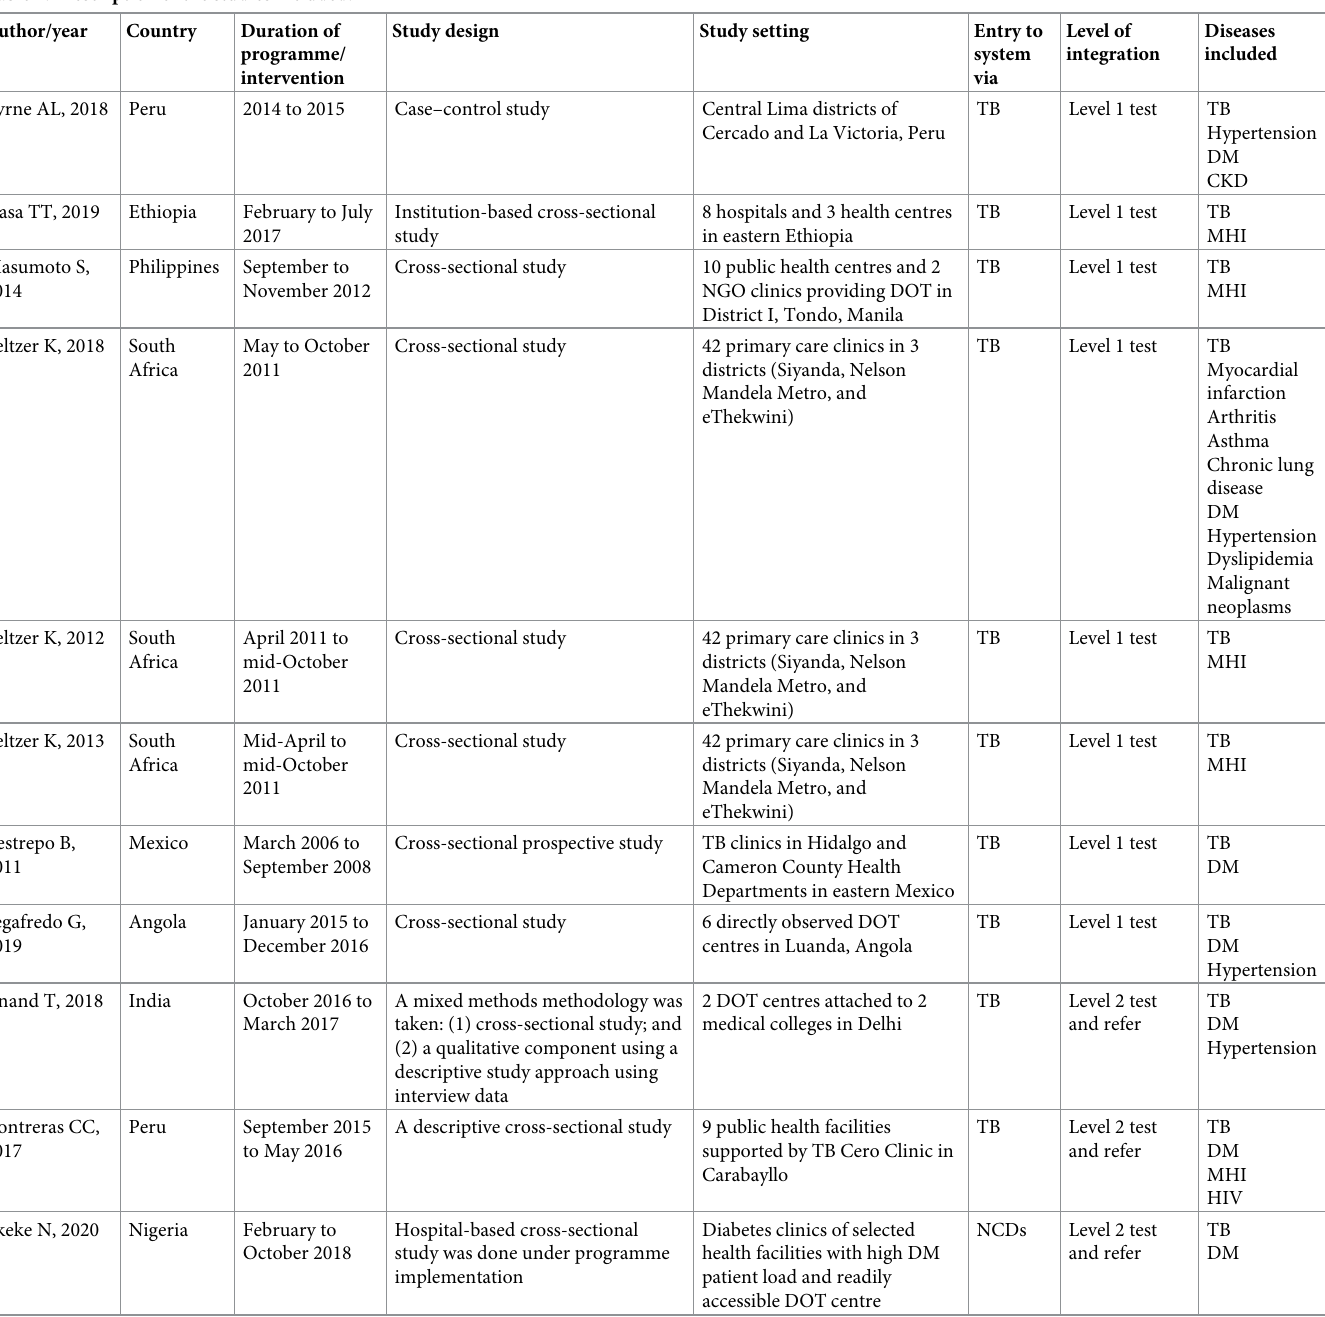
Table 1. Description of the studies